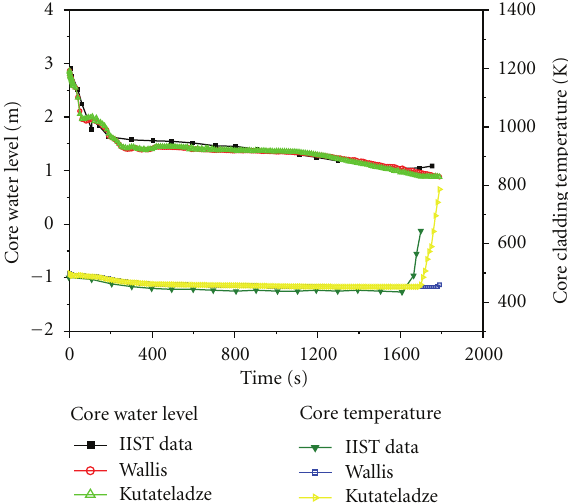
Figure 9: The comparison of core water level and cladding temper- ature among Wallis form, Kutateladze form, and IIST